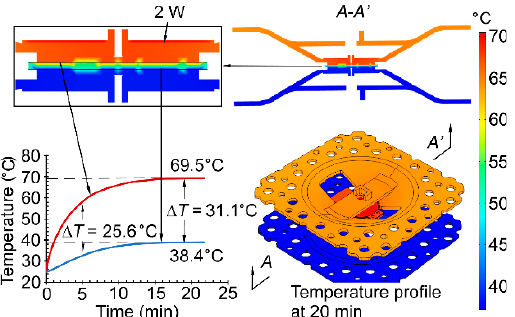
Figure 5. Transient finite element analysis (FEA) of the 3D-KP thermal response in COMSOL. The temperature profiles show that heat is concentrated within the pumping area of the KP. At 20 min, the largest temperature difference ( Δ T ) between the hot and cool sides of the MCE membranes is ≈ 31.1 °C, with a power of 2 W.